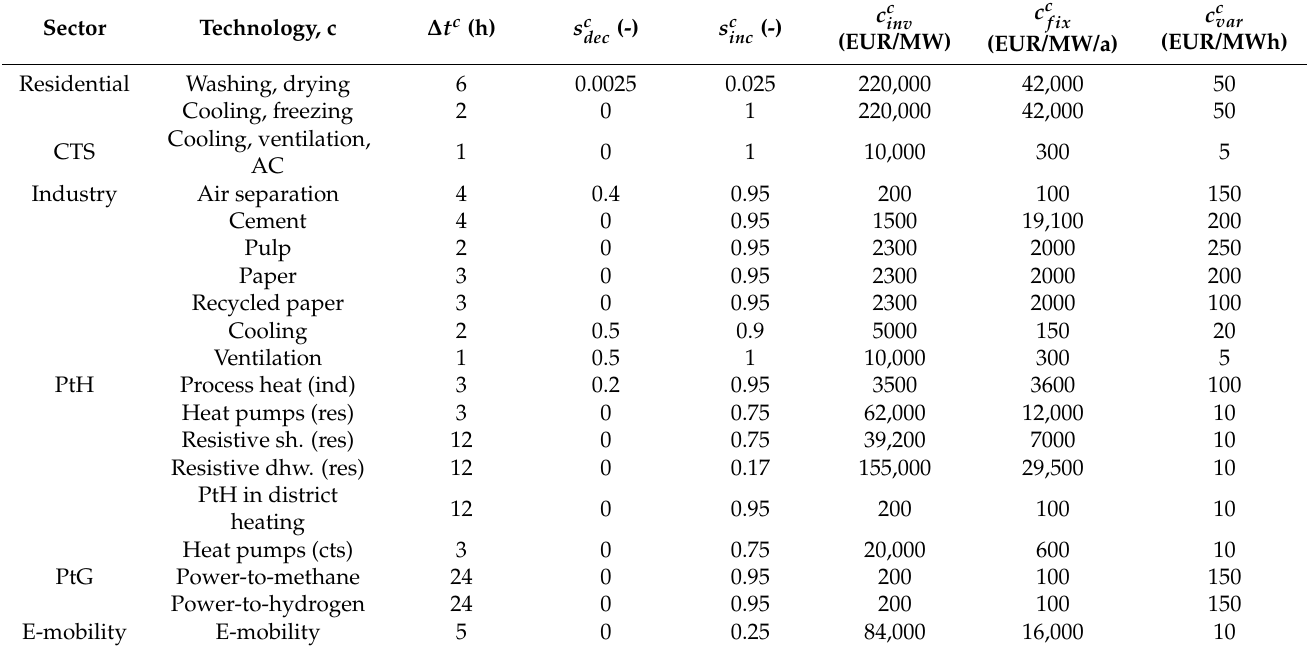
Table 1. Input parameters for modelling the DR process, investment costs, fixed costs and variable costs [25].